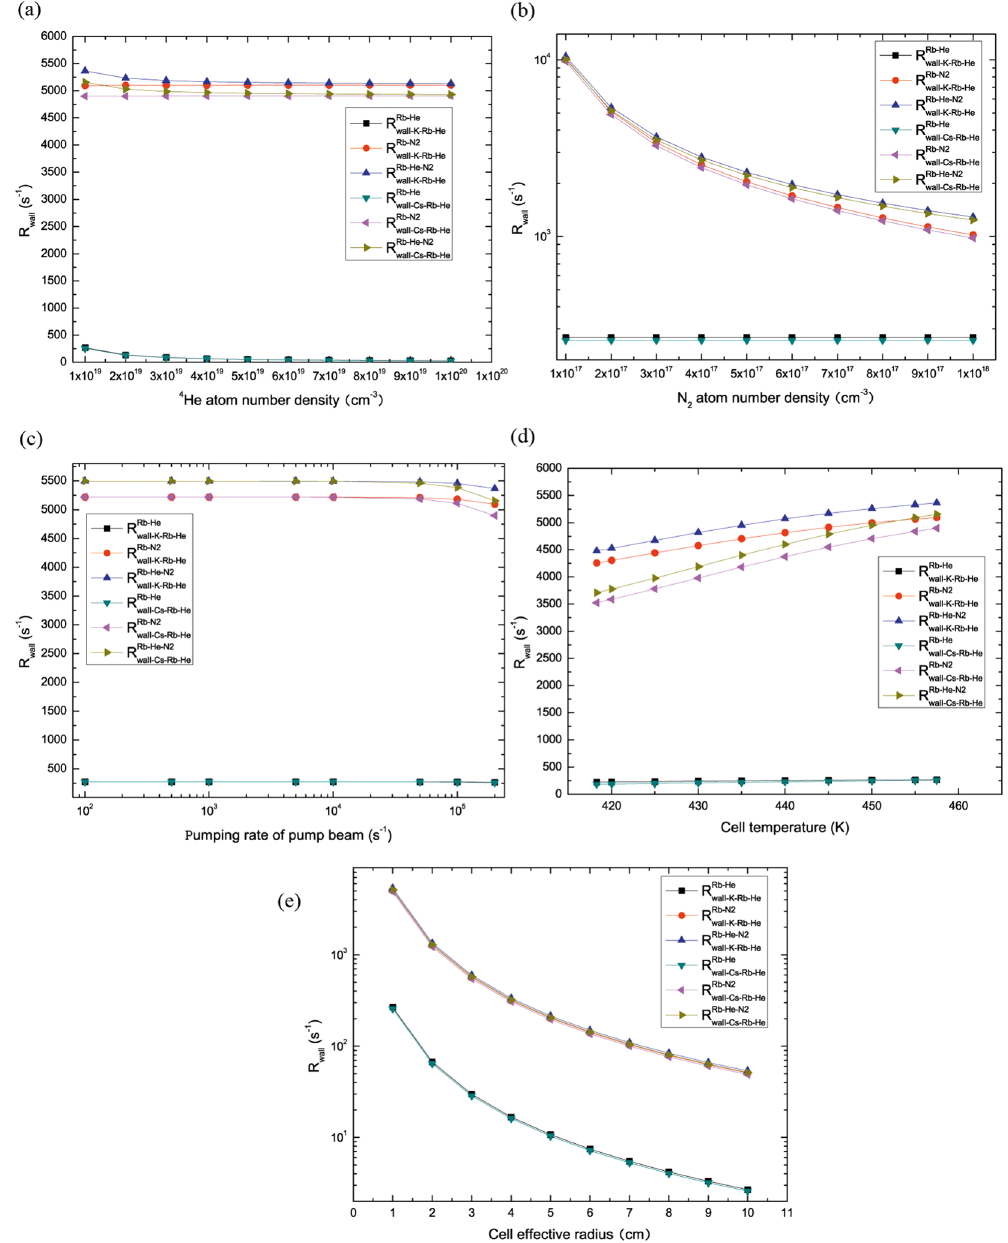
Figure 3. The R wall of 39 K- 85 Rb- 4 He and 133 Cs- 85 Rb- 4 He magnetometers vary with the number density of buffer gas 4 He and quench gas N 2 , pumping rate of pump beam, cell temperature and cell effective radius. ( a )